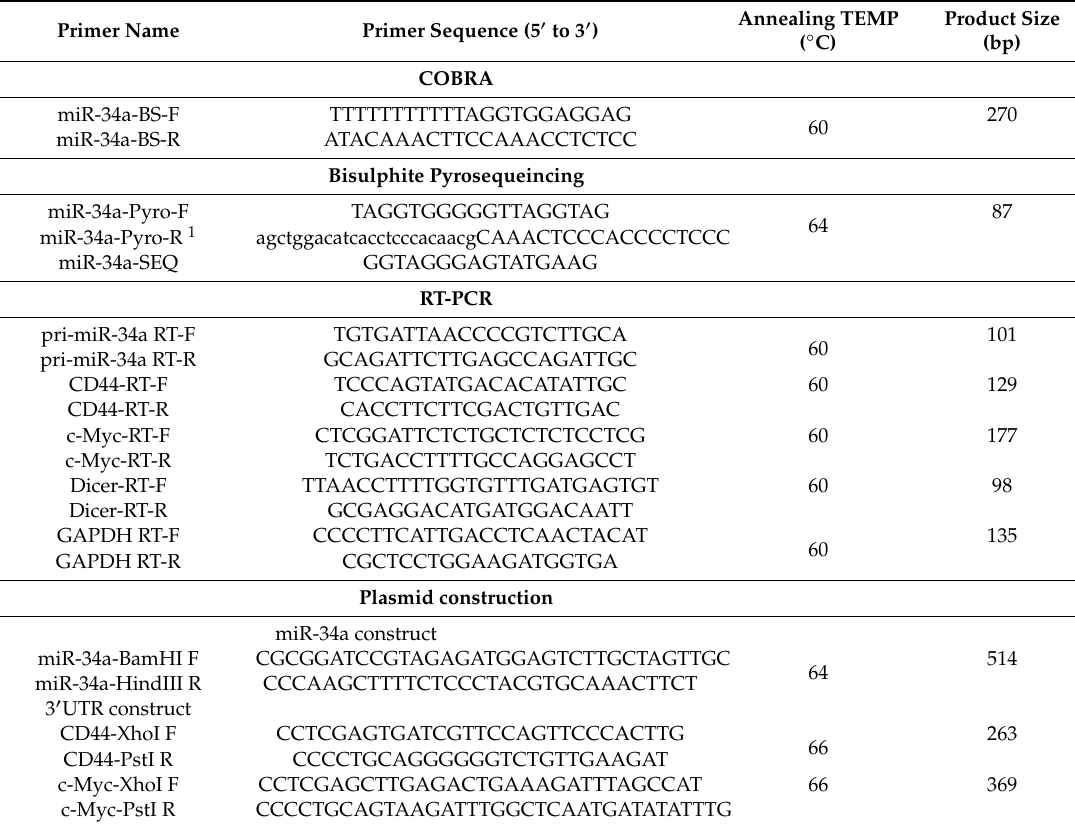
Table 3. Primers used in this